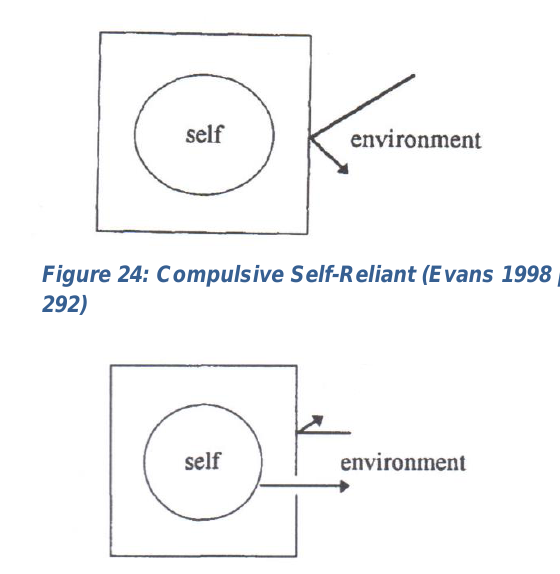
Figure 23: Adaptive Emergent Stage (Evans 1998 p. 291)